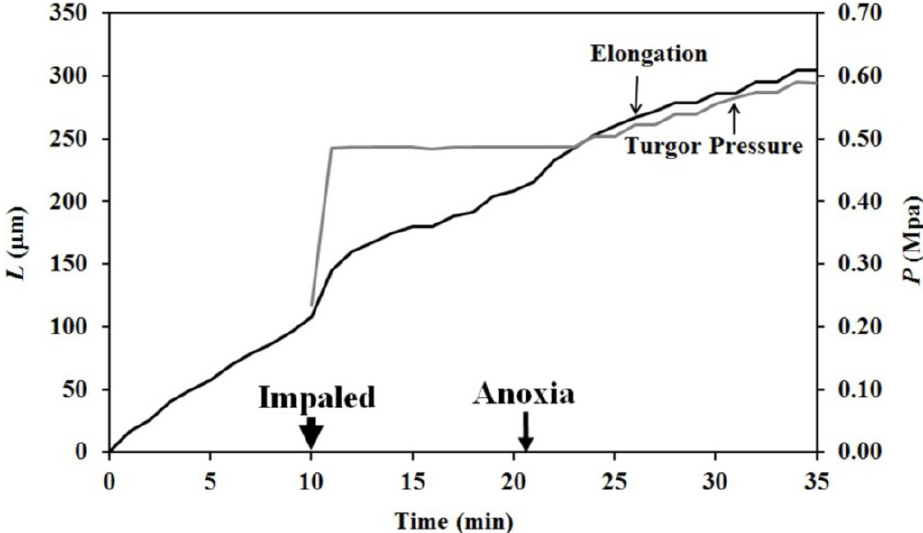
Figure 5. Change in elongation and turgor pressure for a Stage I sporangiophore are plotted as a function of time. Two minutes after anoxia, turgor pressure step-ups (approximately 0.021 MPa in magnitude and 2 min in duration) were produced with the pressure probe.